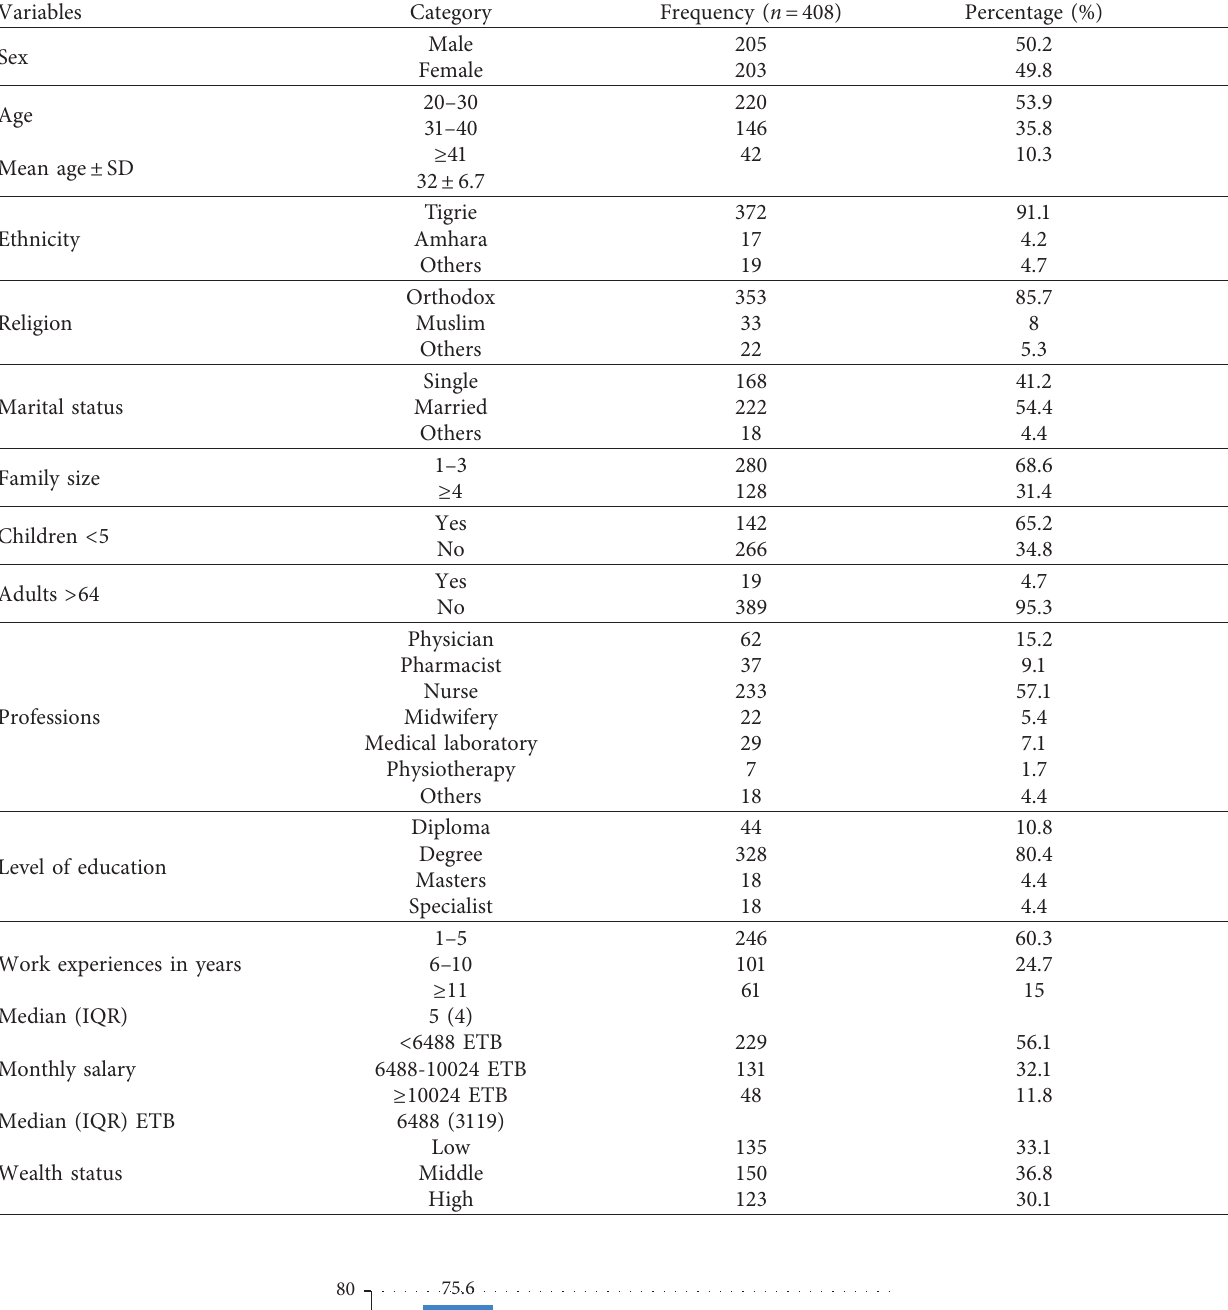
Table 1: Sociodemographic and economic characteristics of health professionals in government hospitals, Mekelle city, North Ethiopia, 2017 ( N � 408).